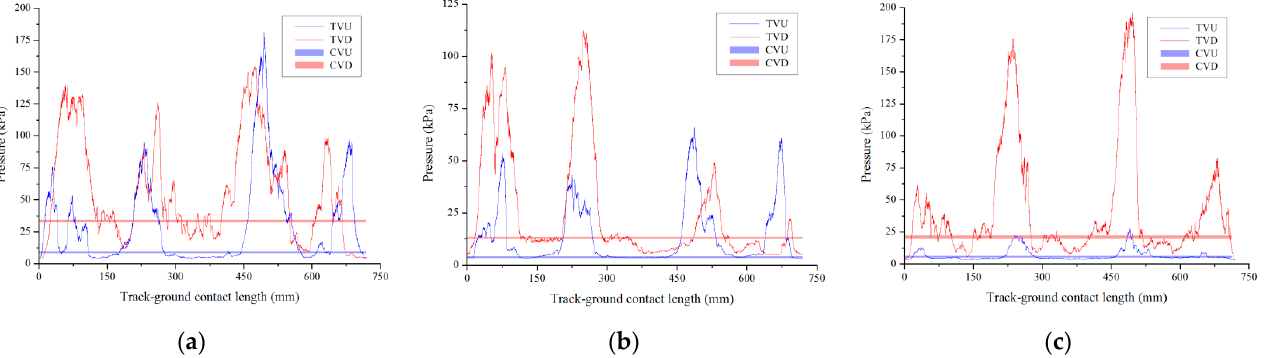
Figure 20. Comparison of measured and calculated pressure. ( a ) Soil water content of 5.2%; bulk density of 1.7 mg·m − 3 ; slope angle of 7.81°; ( b ) Soil water content of 5.8%; bulk density of 1.9 mg·m − 3 ; slope angle of 10.54°; ( c ) Soil water content of 6.4%; bulk density of 1.6 mg·m − 3 ; slope angle of 15.23°.